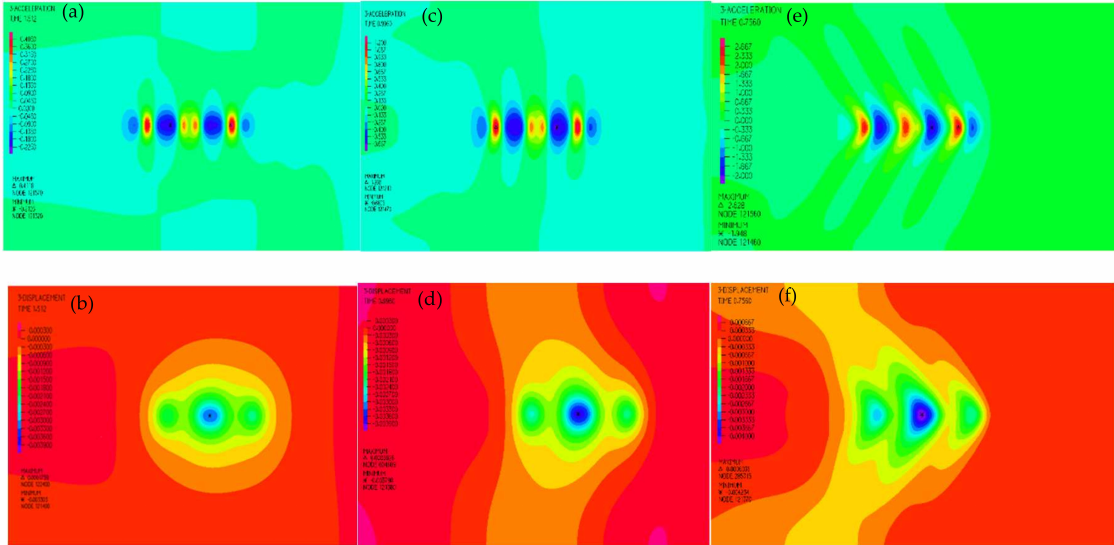
Figure 10. Comparisons of a z and d z at different train speeds. ( a ) a z , E 2 , v = 56 m/s; ( b ) d z , E 2 , v = 56 m/s; ( c ) a z , E 2 , v = 83 m/s; ( d ) d z , E 2 , v = 83 m/s; ( e ) a z , E 2 , v = 112 m/s; ( f ) d z , E 2 , v = 112 m/s.